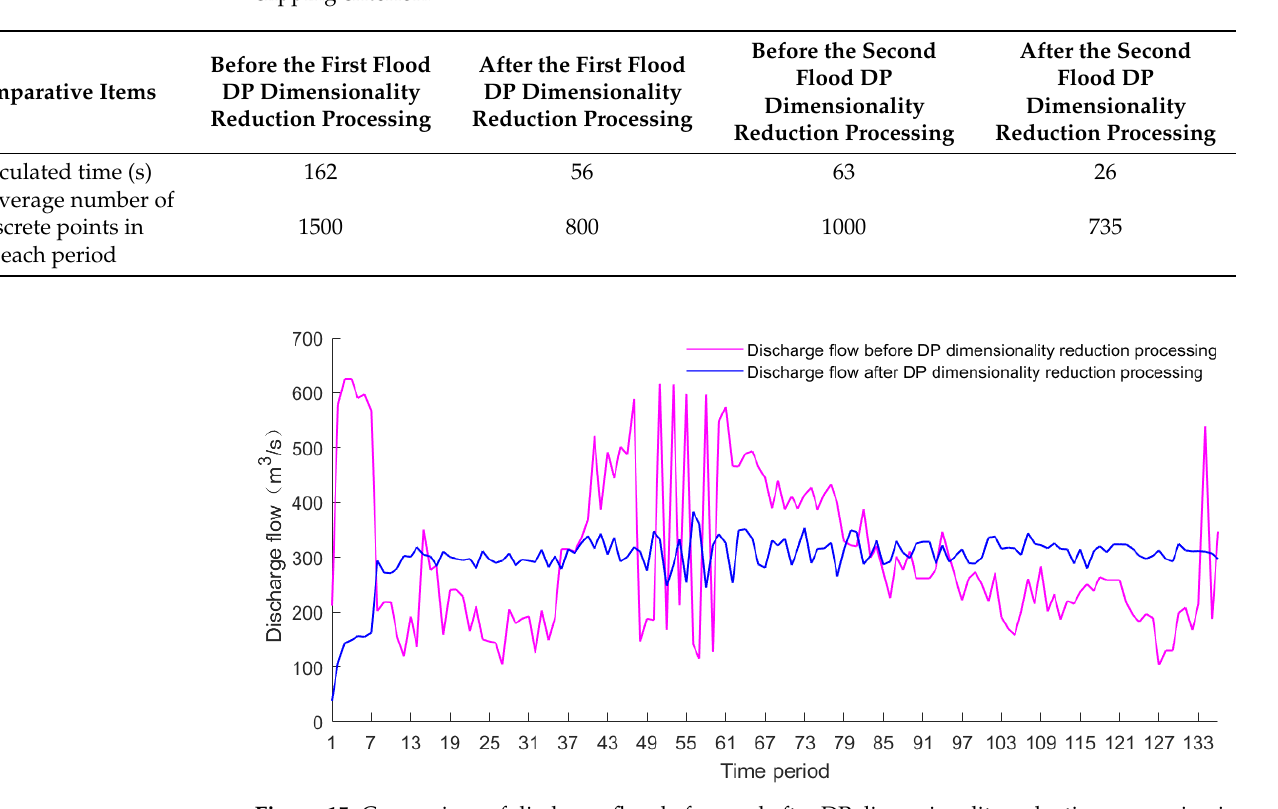
Figure 15. Comparison of discharge flow before and after DP dimensionality reduction processing in the first flood.